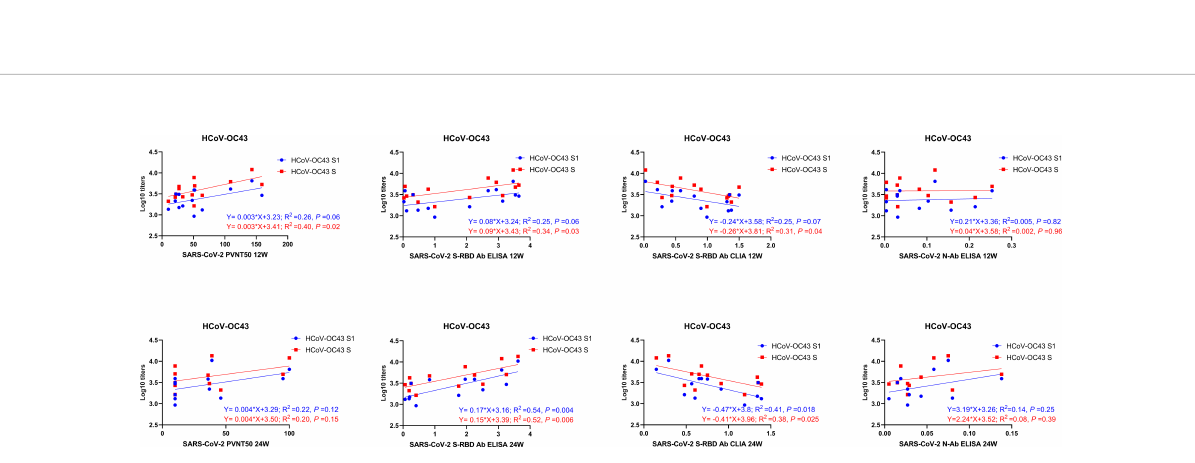
FIGURE 4 Linear correlation of antibody levels between SARS-CoV-2 and HCoV-OC43. The linear correlation between prior S/S1-IgG antibody levels to HCoV-OC43 and S-RBD/N/neutralizing antibodies to SARS-CoV-2 at 12 and 24 weeks after vaccination is shown in the fi gure. A scatter point represents a record. R 2 represents the degree of linear deviation obtained by fi tting the experimental data. The p -value tests whether the regression equation is signi fi cant. The larger the R 2 value, the smaller the p -value. When the p -value is less than 0.05, this linear model can be considered